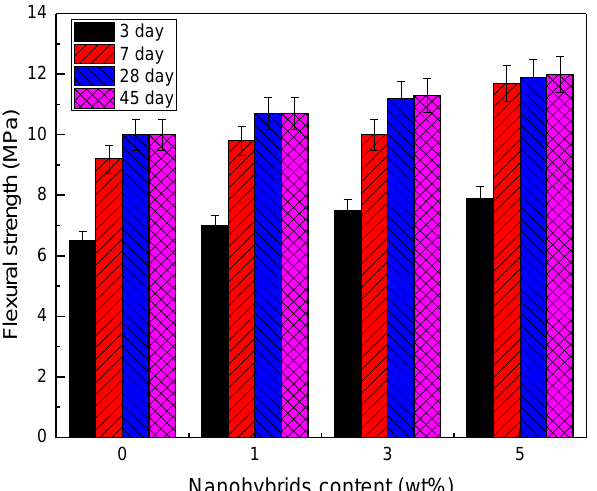
Figure 6. Flexural strength of cement pastes with different nanohybrid contents at 3, 7, 28, and 45 days.